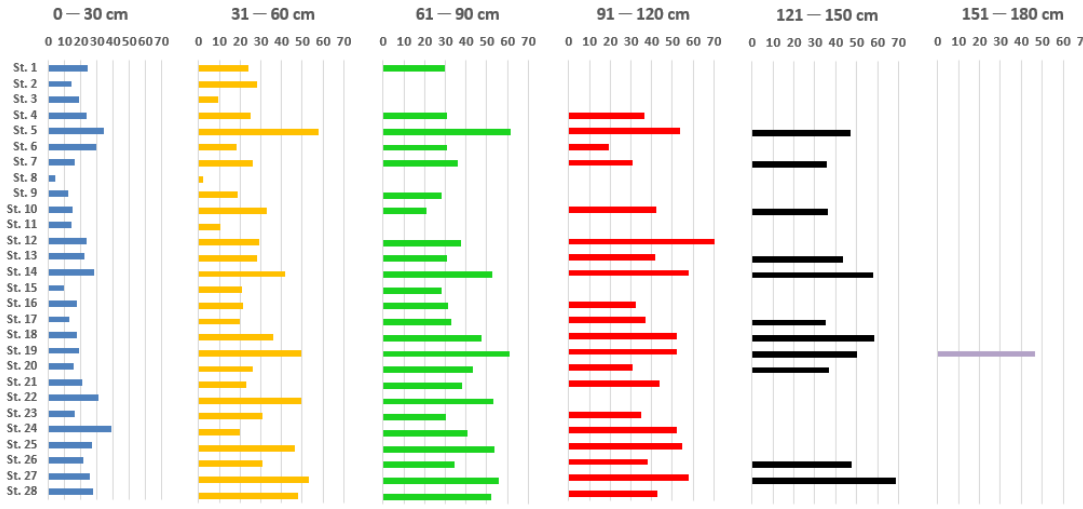
Figure 5. Mean content of total nitrogen in the interstitial water of Karczemne Lake (mg N L -1 ).